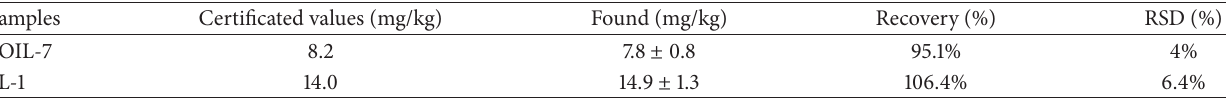
Table 4: Determination of Th(IV) in the standard samples.